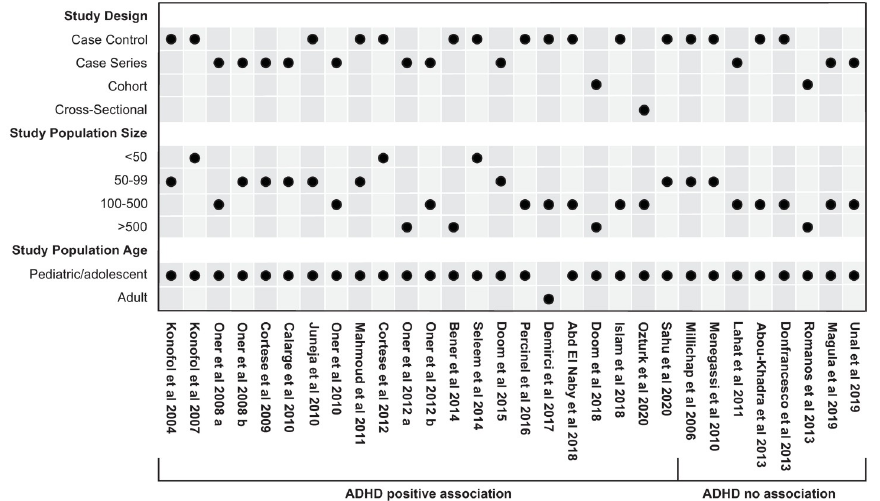
Fig 2. Overview of ADHD association studies. Pediatric/adolescent studies: Age 19 years or less; adult studies: Age 19 years or